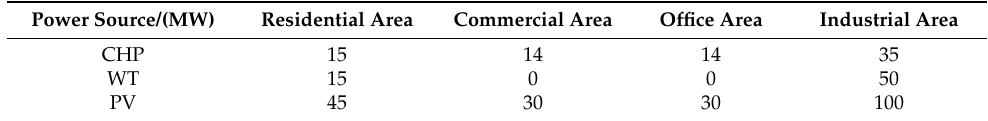
Table 1. Power configuration of each functional area.